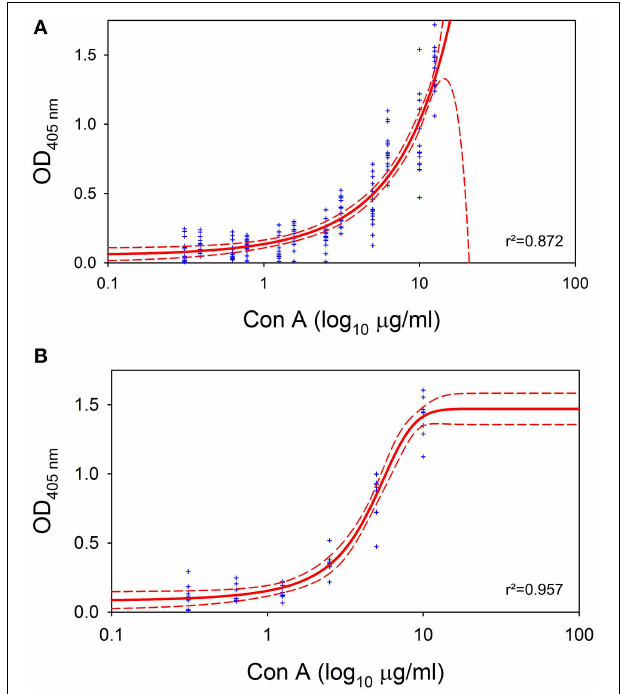
FIGURE 3 | Enzyme-linked lectinsorbent assay (ELLA). ELLA applied on 72h E. faecalis and A. naeslundii monospecies biofilms for confirmation of EPS. Blue dots represent original measured values, red solid line represents the fit of the sigmoideal curve and red dashed lines depict 95% confidence intervals. r 2 denotes the correlation coefficient. (A) ELLA on E. faecalis monospecies biofilm. (B) ELLA on A. naeslundii monospecies